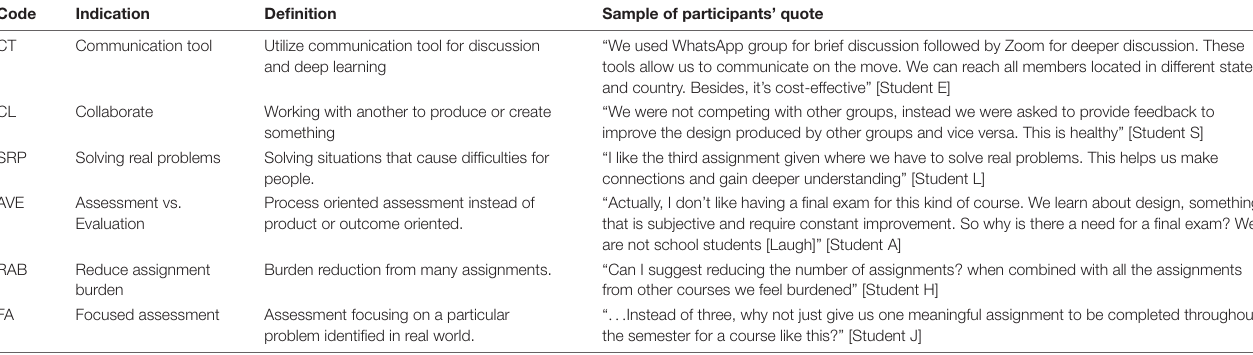
TABLE 3 | Codes and indications from semi-structured interviews. Code